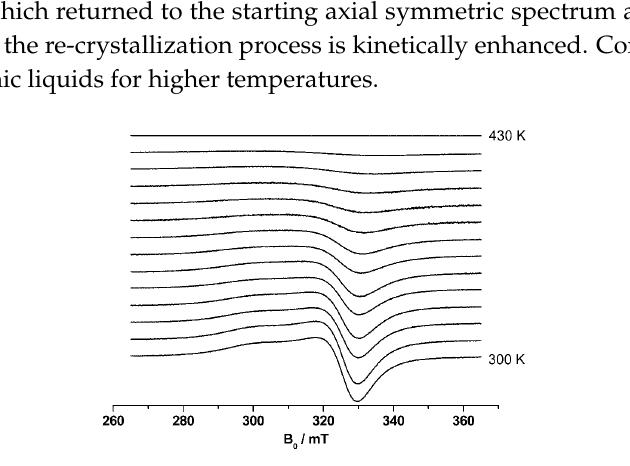
Figure 5. Temperature dependent EPR spectra of (EtPh 3 P) 2 [CuBr 4 ] ( 7 ) recorded in the temperature range from 300 to 430 K (10 K steps).